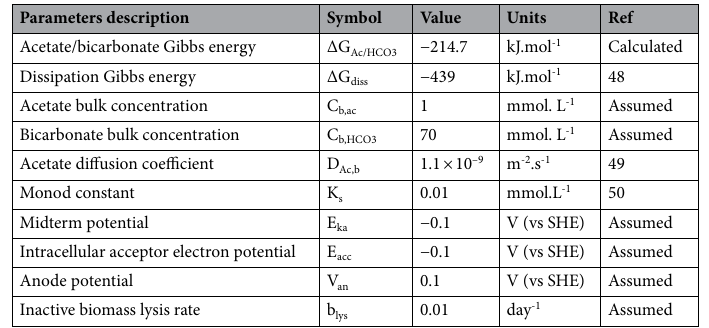
Table 1. Summary of the parameters used in the